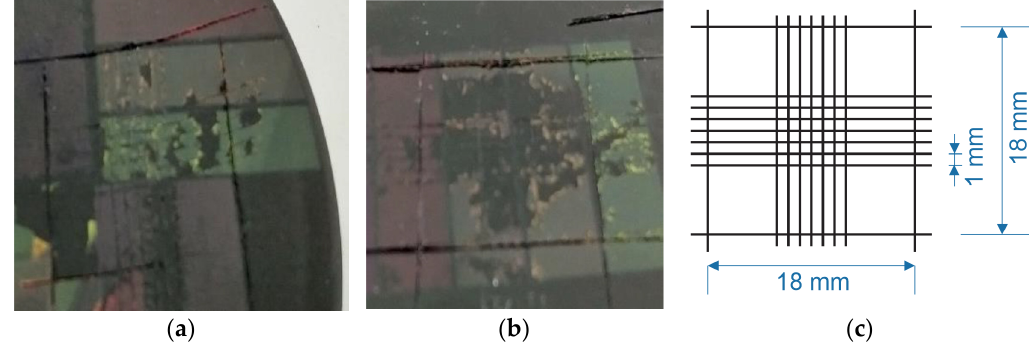
Figure 5. Cross-Cut testing of PET material. Comparison of IPA cleaned PET polymer ( a ) Cross-Cut test direct after printing (GT2); ( b ) Cross-Cut test 24 h. after printing (GT4); ( c ) Cross-Cut dimensions.